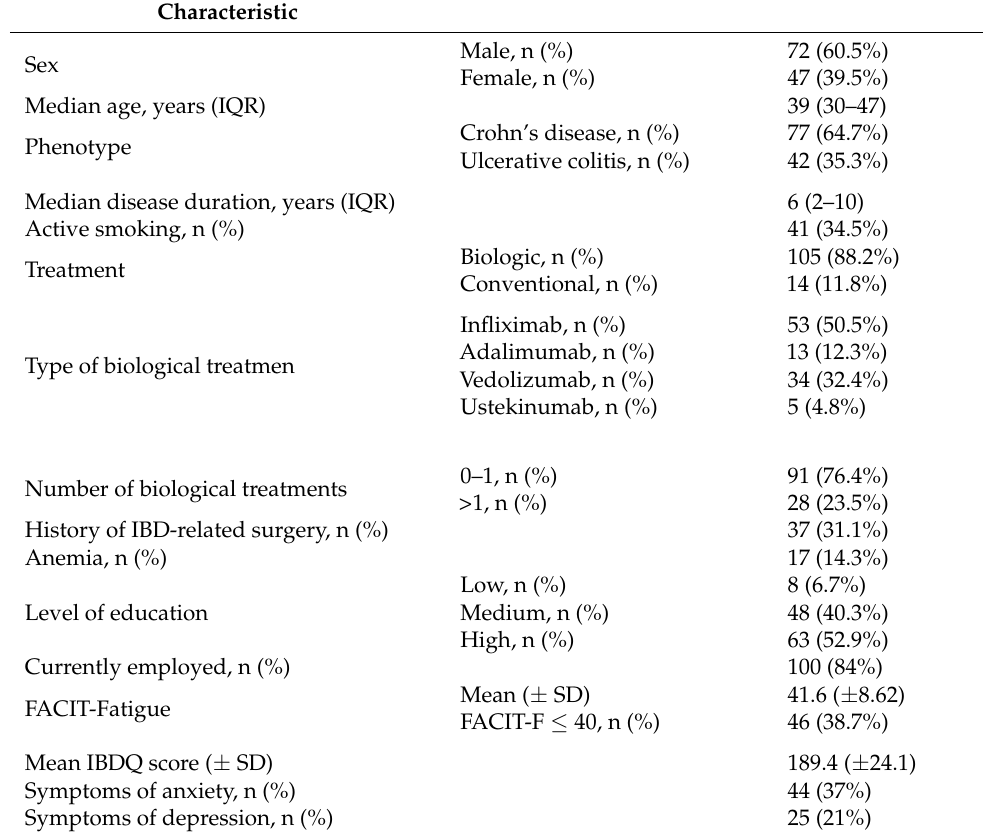
Table 1. Characteristics of the study